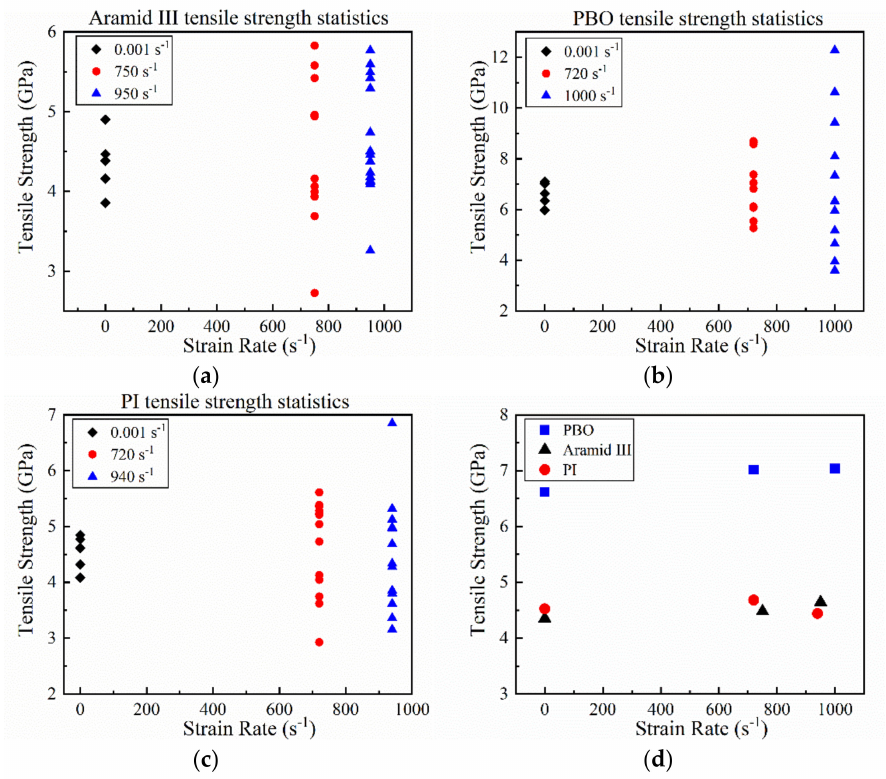
Figure 5. Tensile strengths of ( a ) aramid III fibers at quasi-static, 750 s − 1 , and 950 s − 1 ; ( b ) PBO fibers at quasi-static, 720 s − 1 , and 1000 s − 1 ; ( c ) PI fibers at quasi-static, 720 s − 1 , and 940 s − 1 ; and ( d ) average strength versus strain